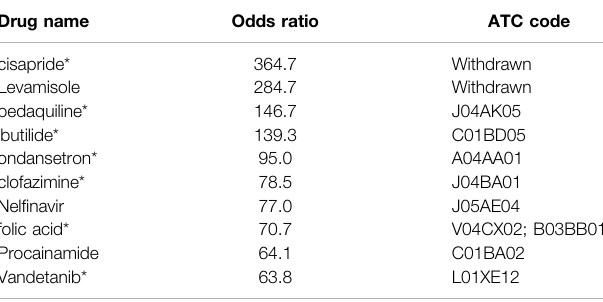
TABLE 3 | The information of top ten drugs with high teratogenic risk in FAERS.